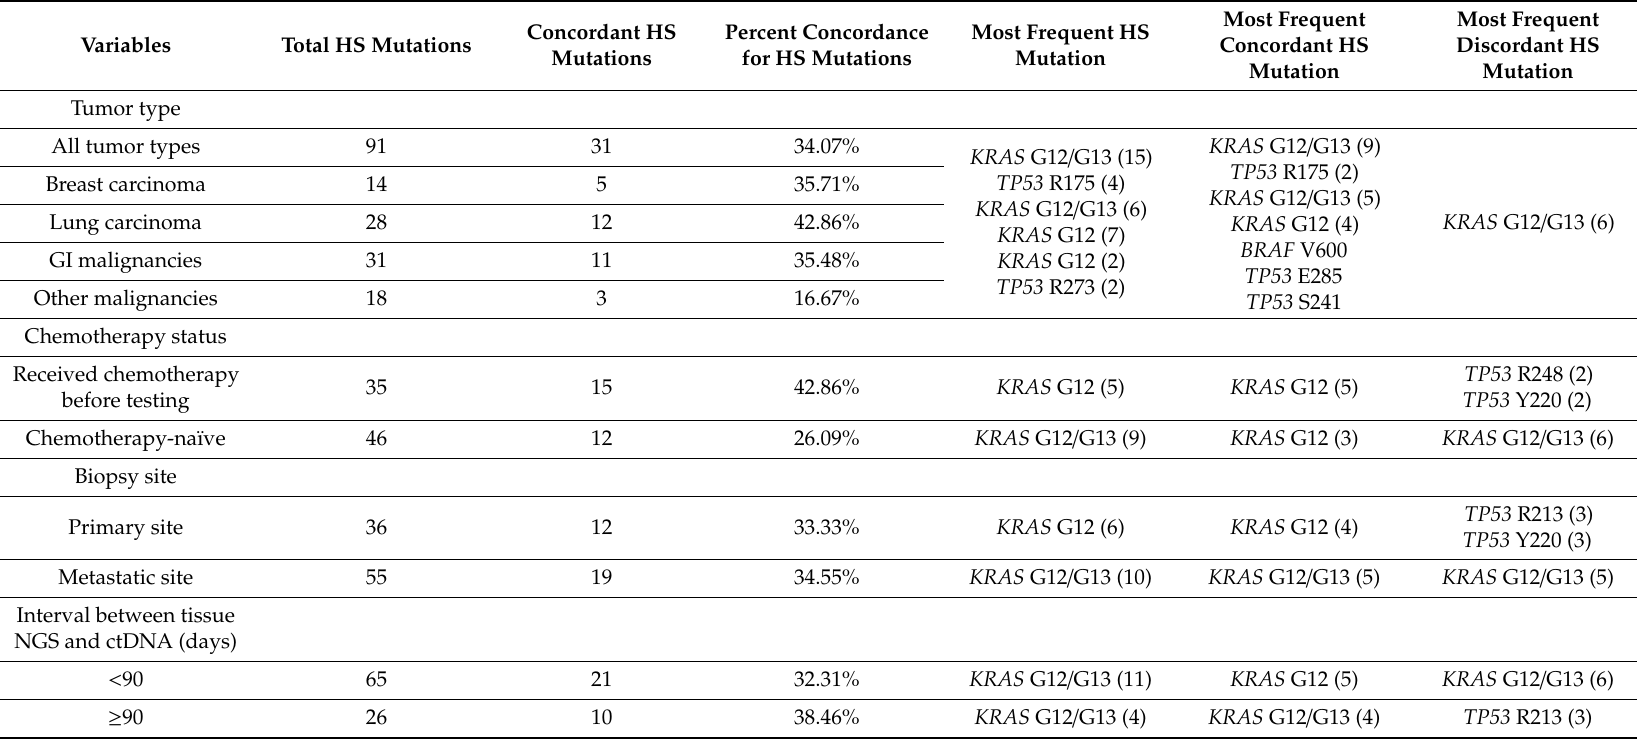
Most Frequent Most Frequent Concordant HS Percent Concordance Most Frequent HS Concordant HS Discordant HS Mutations for HS Mutations Mutation Mutation Mutation